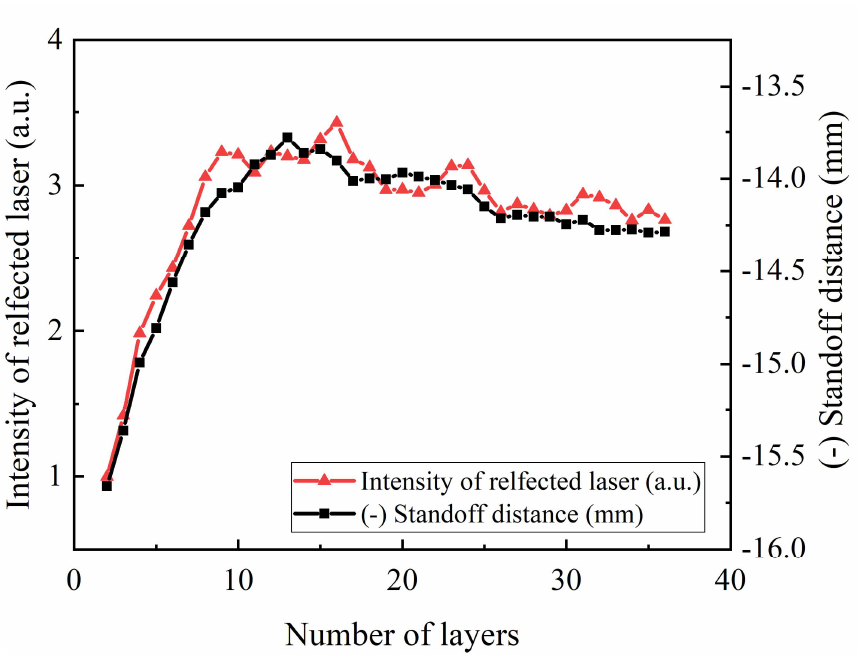
Figure 12. Relationship between standoff distance and mean intensity of reflected laser.